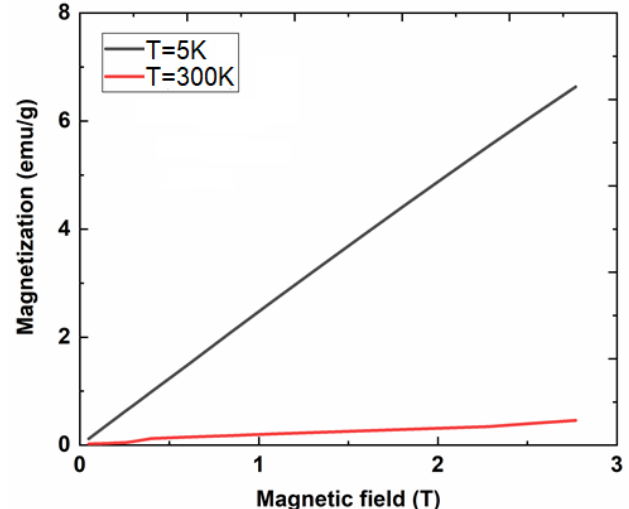
Figure 5. Magnetization vs. magnetic field dependence measured at T = 300 K and T = 5 K recorded on CeF 3 :Tb nanocrystalline powder calcinated at 400 °C.